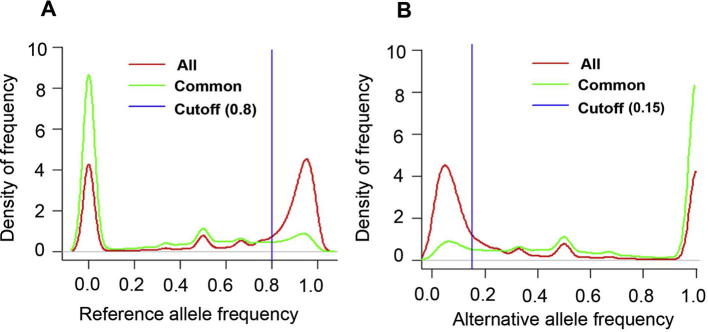
The density of allele frequency The density of reference allele frequency and alternative allele frequency is shown in A and B, respectively. “All” means all candidate variants, “Common” means common variants in dbSNP. To reduce the false positive rate of variant identification, cutoff values were set to 0.8 for reference allele frequency and 0.15 for alternative allele frequency. Variants with frequency >0.8 for reference allele and <0.15 for alternative allele were removed.